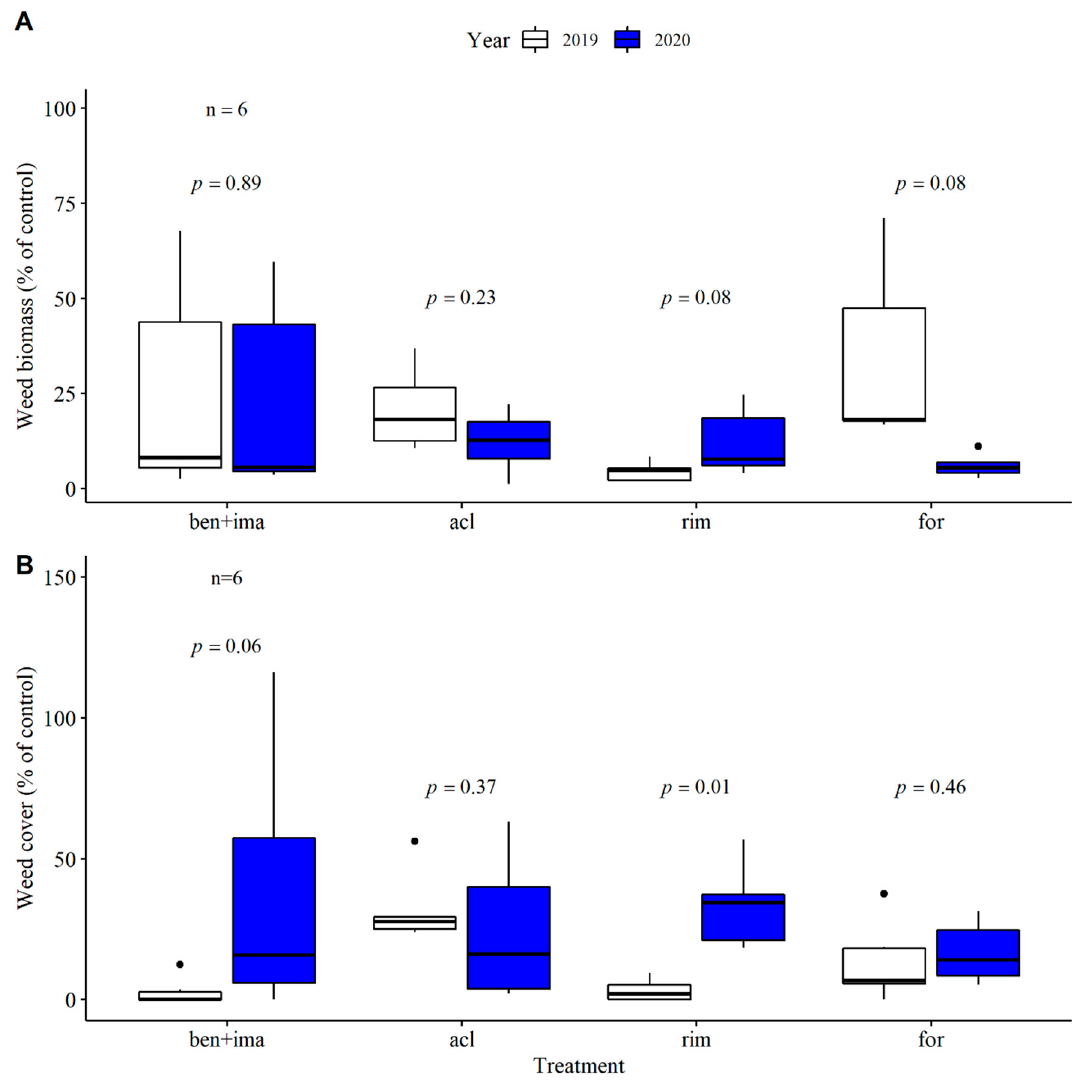
Figure 3. Effect of POST herbicides application on ( A ) weed biomass, and ( B ) weed cover. Treatments included: bentazon + imazamox (ben + ima), aclonifen (acl), rimsulfuron (rim), and foramsulfuron (for). Comparisons between years within a treatment were assessed using a t-test ( n = 6).